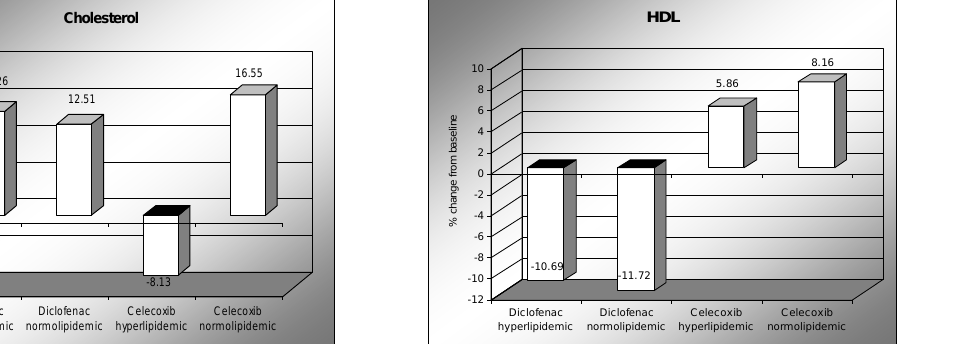
Figure (1): - The % changes in serum total cholesterol concentration from baseline value after 8weeks treatment with diclofenac or celecoxib in hyperlipidemic and normolipidemic type 2 diabetic patients